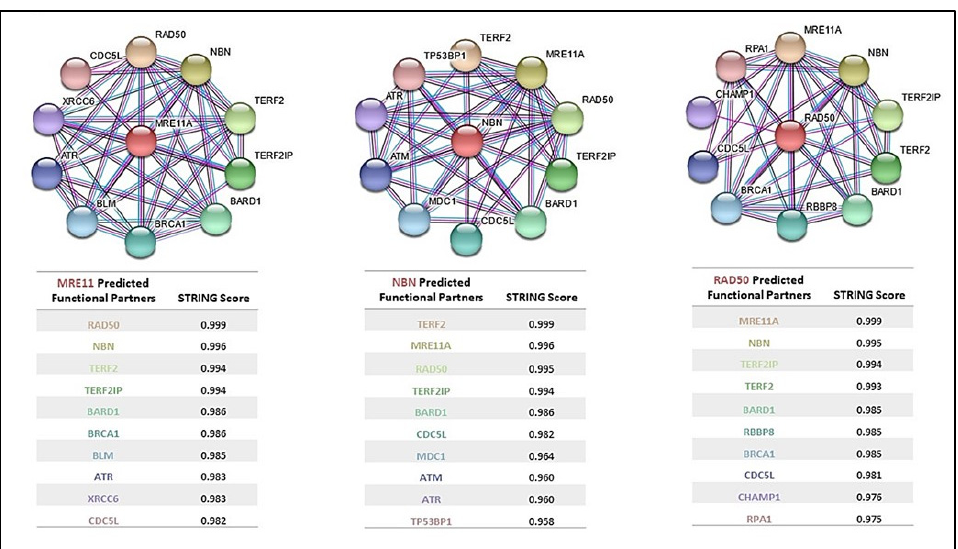
Figure 5. STRING Protein–Protein Interaction Networks of MRE11 (MRE11A), NBS1 (NBN), and RAD50. Each network and its subsequent table contain the top 10 predicted functional partners (PFP) of MRE11, NBS1, and RAD50 according to STRING (v11.0) https://string-db.org/ (accessed on 1 June 2022). Interacting Lines represent know interactions from curated databases (blue), experimentally determined (pink), or by co-expression (black). Scores represent the level of confidence a likely interaction is true on a scale of 0 to 1, with 1 being the highest possible confidence.